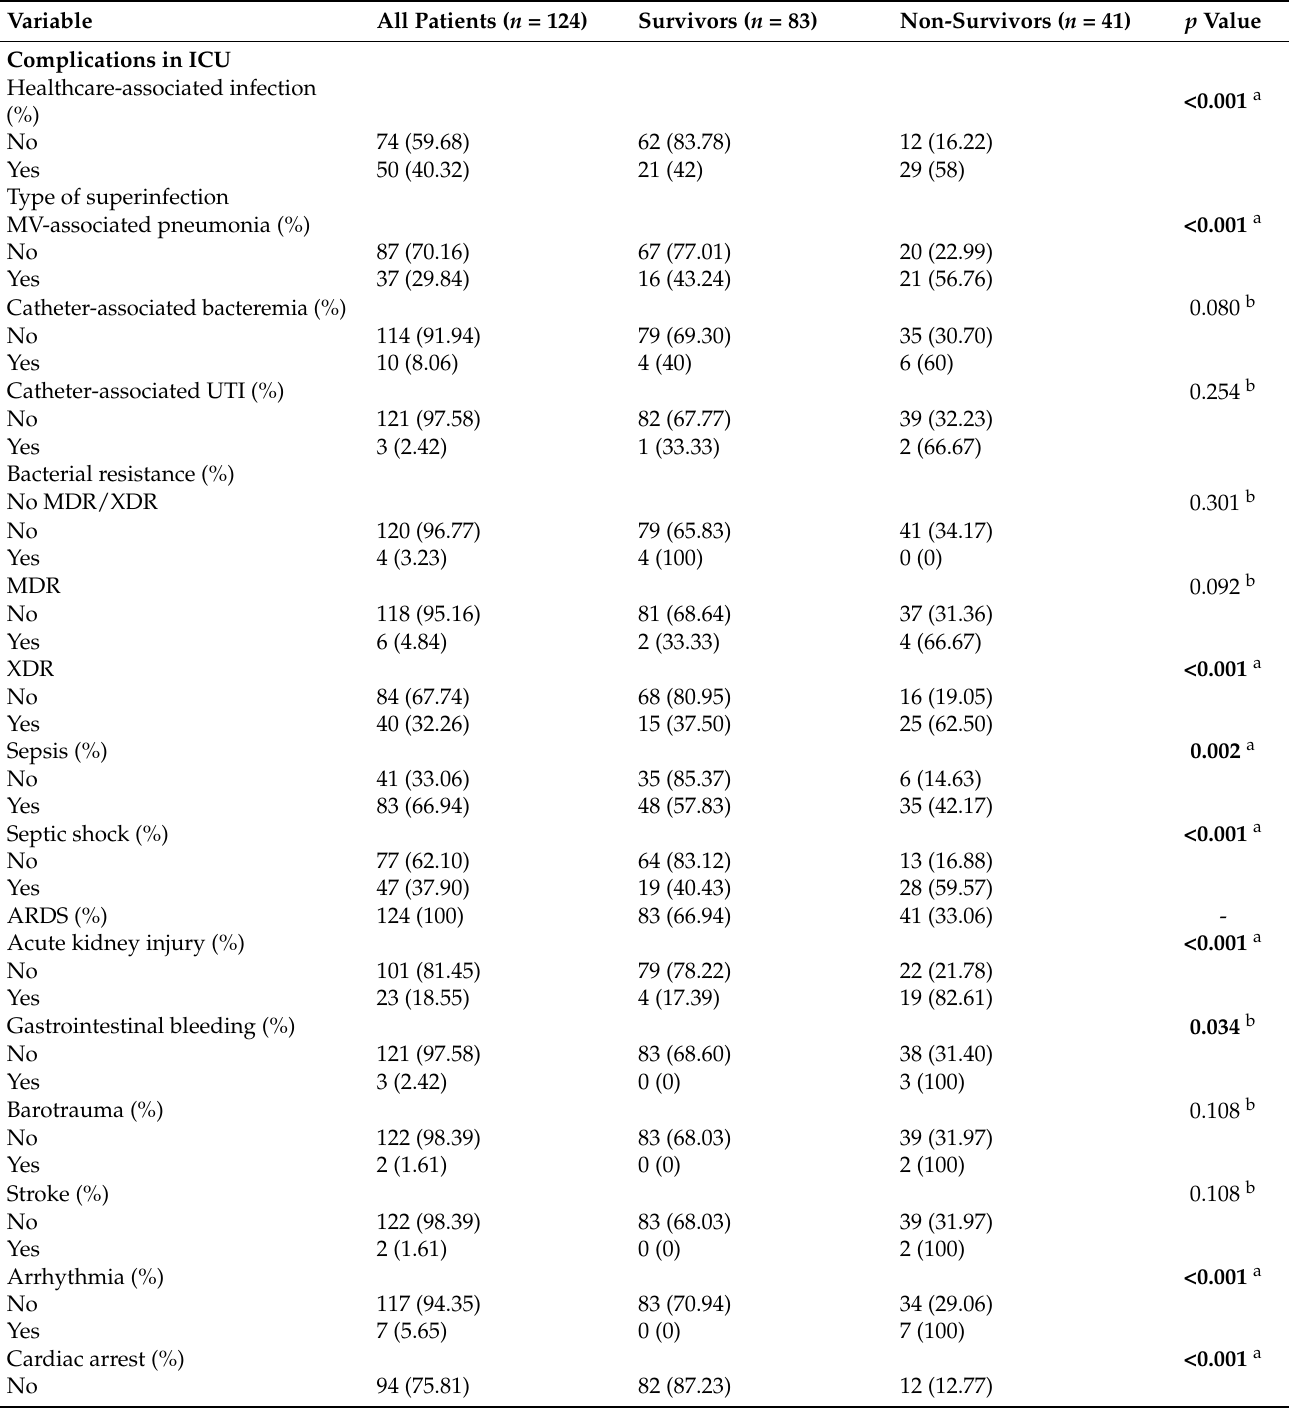
Table 2. Complications and treatment received during ICU stay in the study population and comparison between survivors and